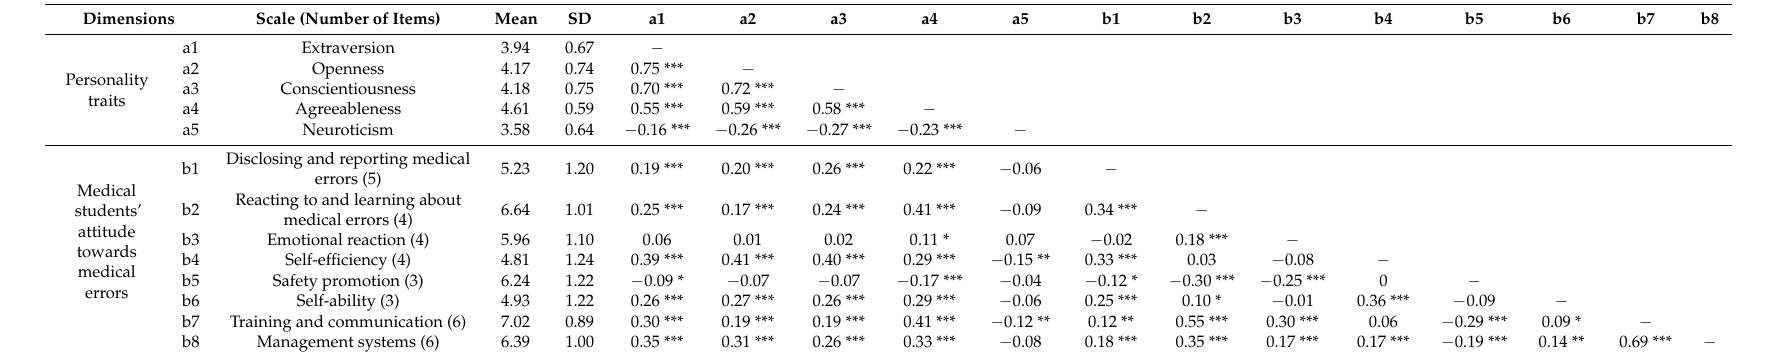
Table 2. Means, standard deviations and correlation matrices for combined data with n = 493.